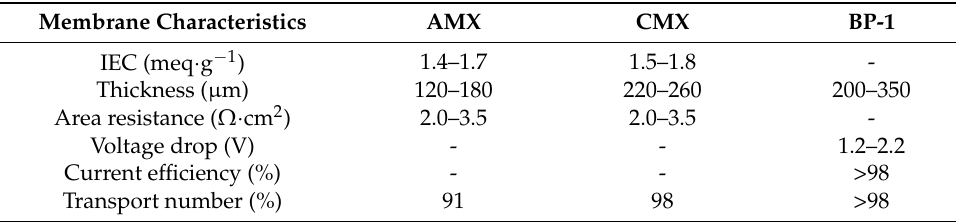
Table 1. Properties of the membranes used in the BMED experiments a